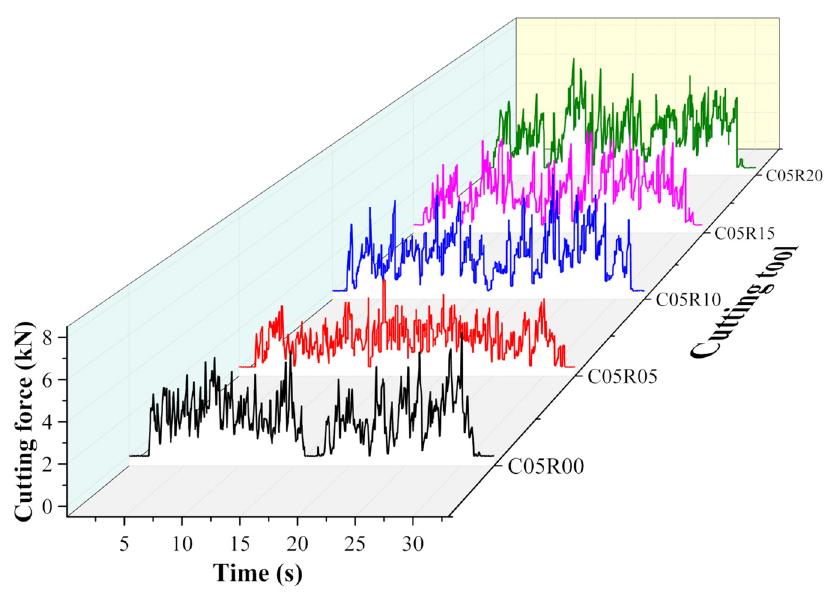
Figure 8. Variation in the cutting force with time for each rake angle.